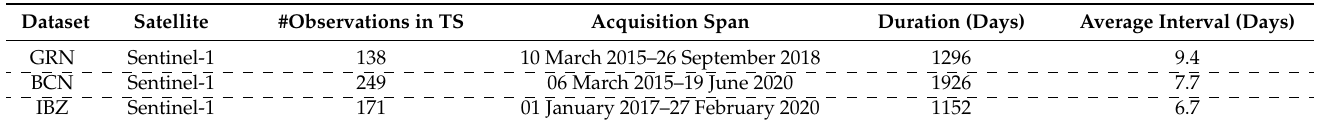
Table 1. Characteristics of the three SAR datasets, along with the duration and average interval of interferograms.